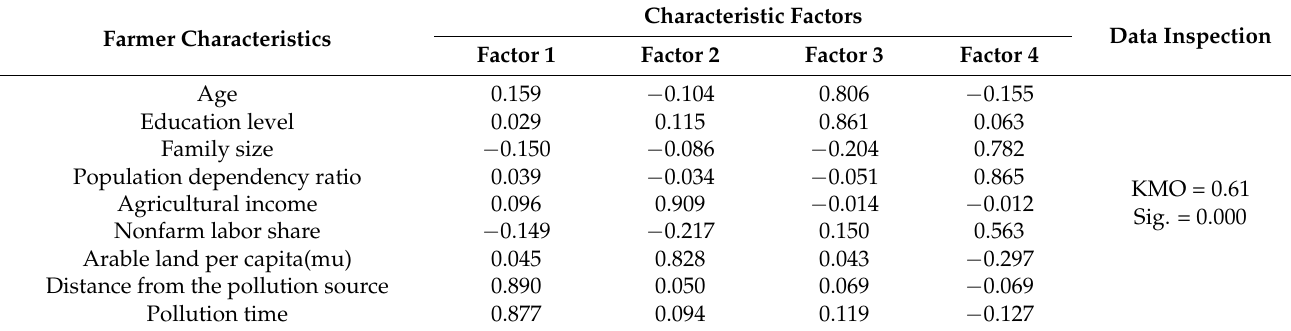
Table 3. Results of factor analysis of farmers’